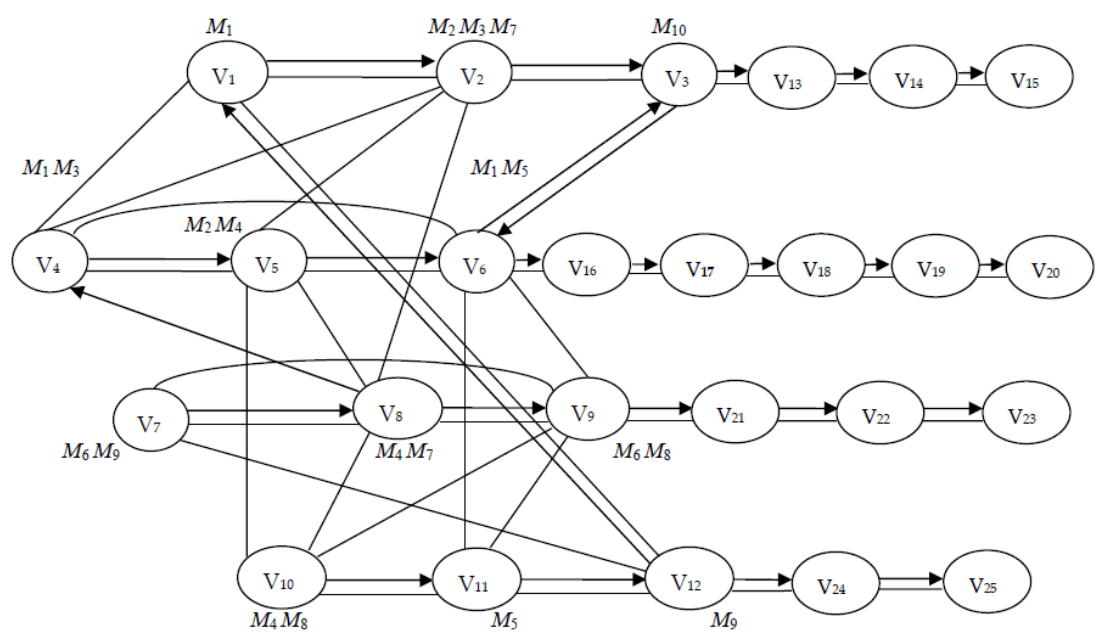
Figure 4. Mixed graph G ∗ = ( V ∗ , A ∗ , E ∗ ) , whose optimal coloring c ( G ) determines an optimal schedule for the problem GcMPT | t i = 1, [ d i ] | L max constructed in the proof of Theorem 7.